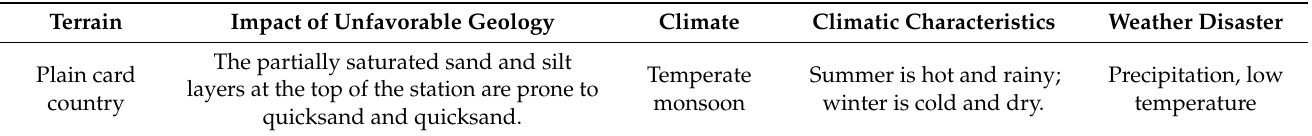
Table 2. The terrain and climate characteristics of the area where the subway station is located.